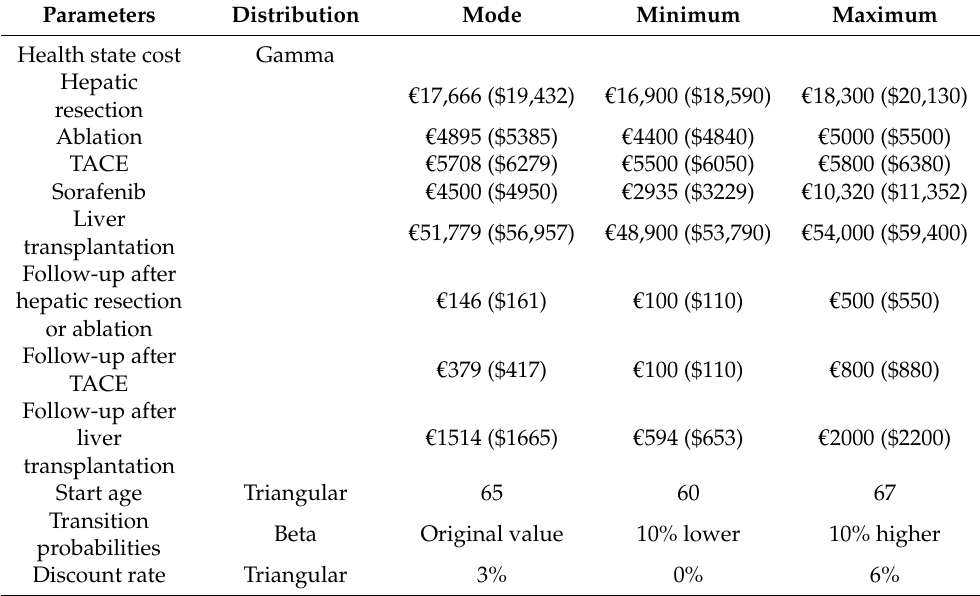
Table 3. Input parameters values, distribution, and boundaries for probabilistic sensitivity